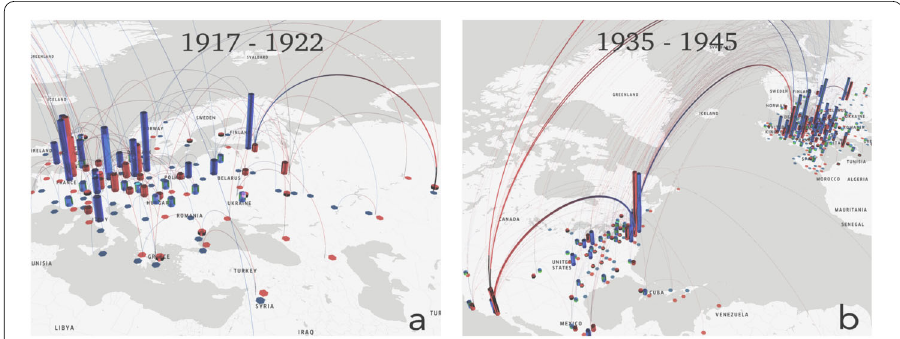
Figure 3 A representation of the spatial directed network encoding the mobility information of the chosen set of notable people during the first half of the 20th century. We use the blue hexagon to indicate the source point and the red to indicate the destination of the migratory jump. In this figure, we present the network structure considering the migratory events during two different time snapshots. Panel ( A ) on the left shows the escaping and exiling from Saint Petersburg of the aristocratic families during the years of the red revolution. Similarly, panel ( B ) on the right shows the migration flows from Europe to North America during World War 2, due to the fascist regimes and